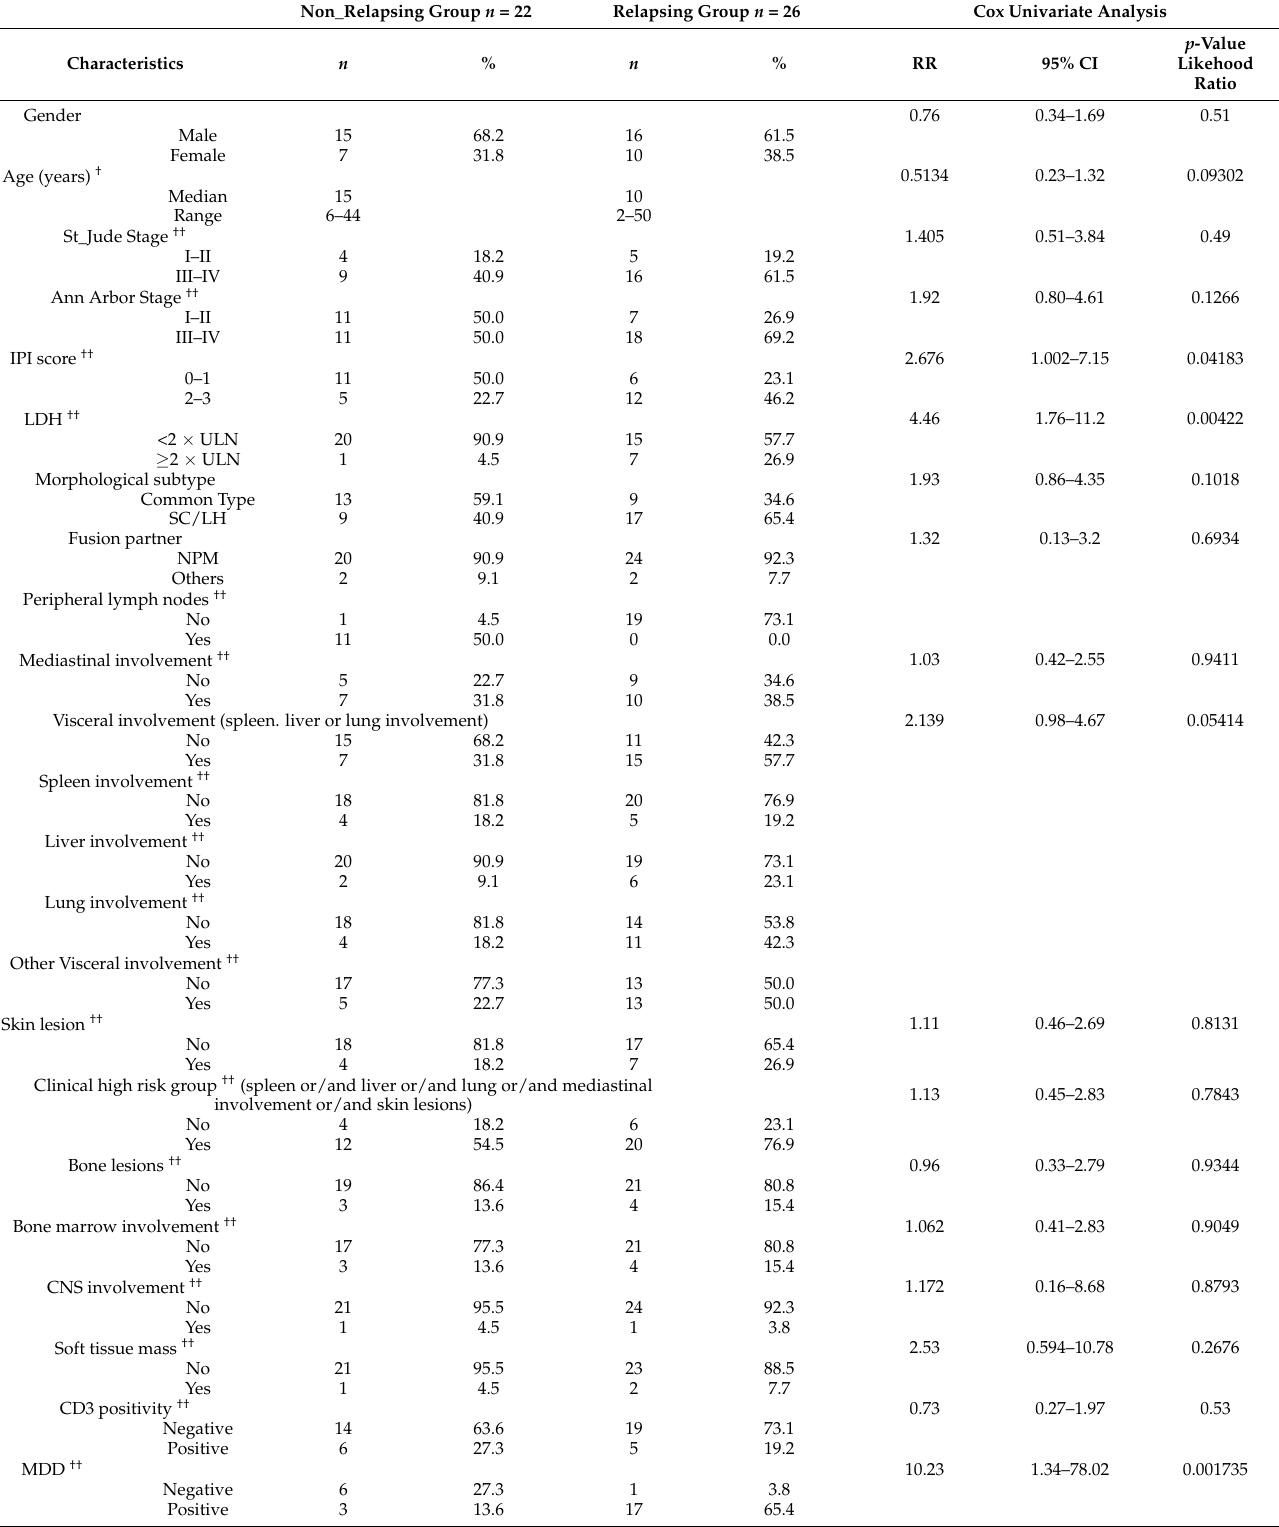
Table 1. Clinical and pathological characteristics of patients and univariate